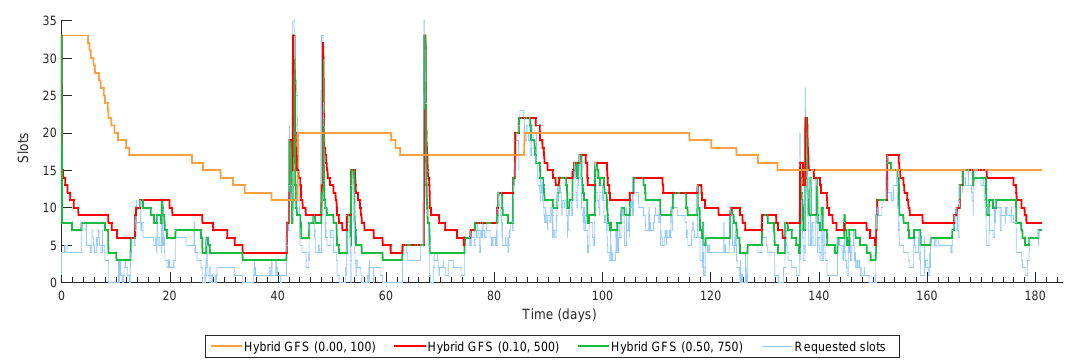
Figure 8. Cluster simulation trace for the test set of the CMS cluster workload